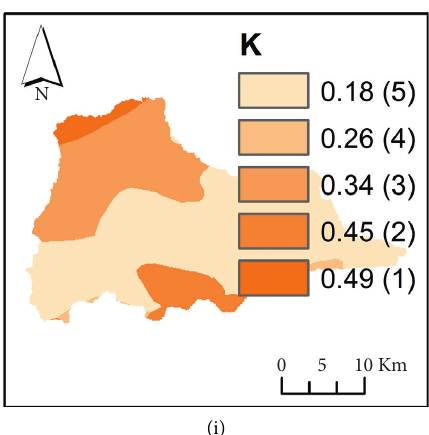
Figure 6: Reclassified flood causing factors based on flood vulnerability assessment: (a) rainfall, (b) LULC, (c) TWI, (d) SPI, (e) elevation, (f) geomorphology, (g) lithology, (h) distance from roads, and (i)